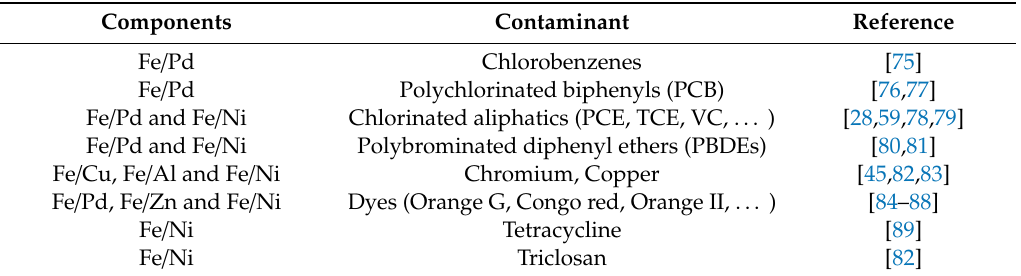
Table 2. Summary of the main pollutants treated with bimetallic iron-based nanoparticles (BNPs).